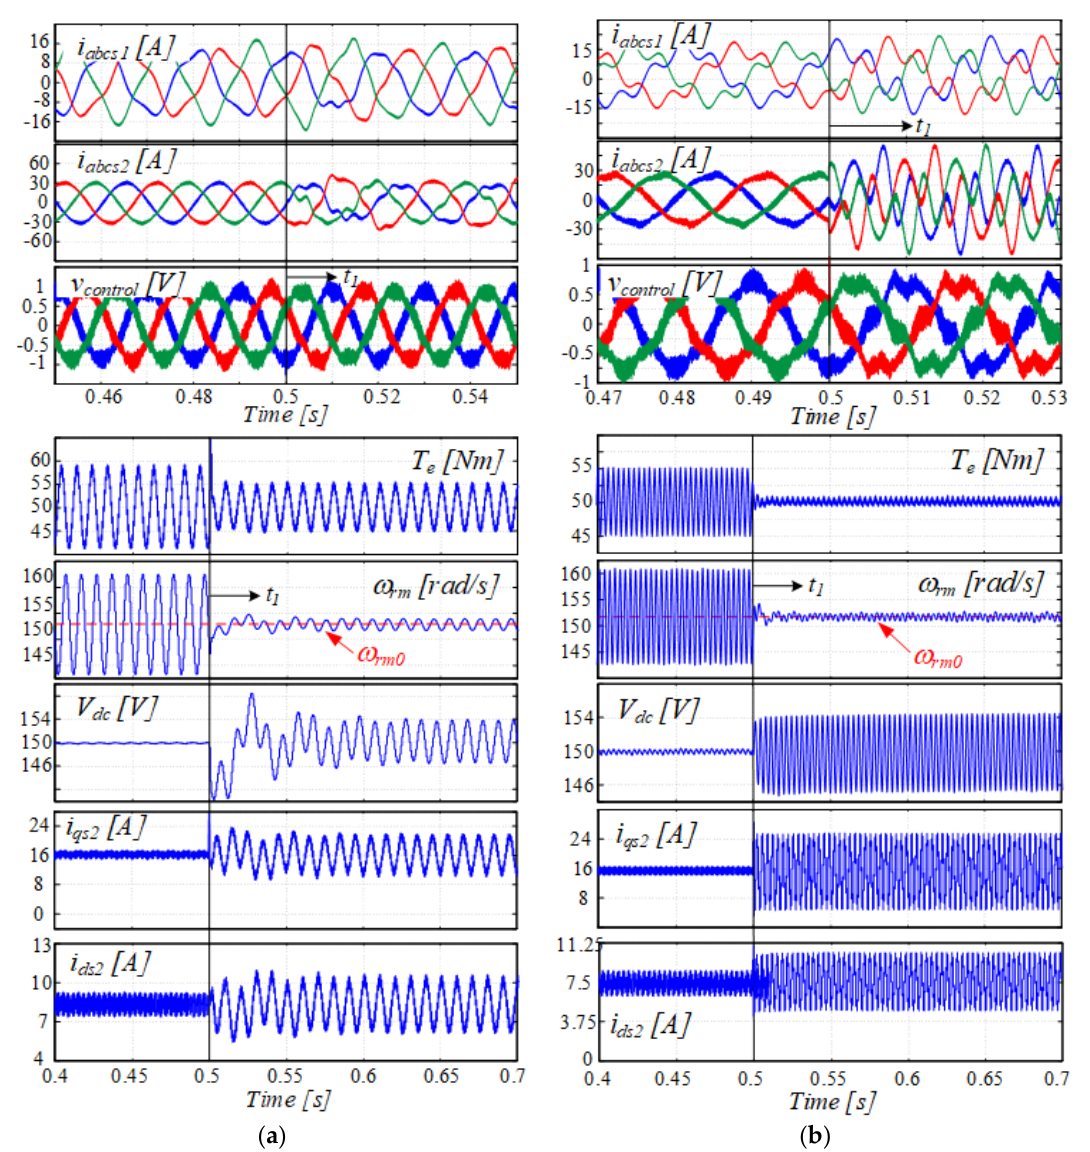
Figure 13. Simulation results: ( a ) compensation of ω rm with ∆ TL = 20 Nm ; ( b ) compensation of ω rm with Vabc5th = 30